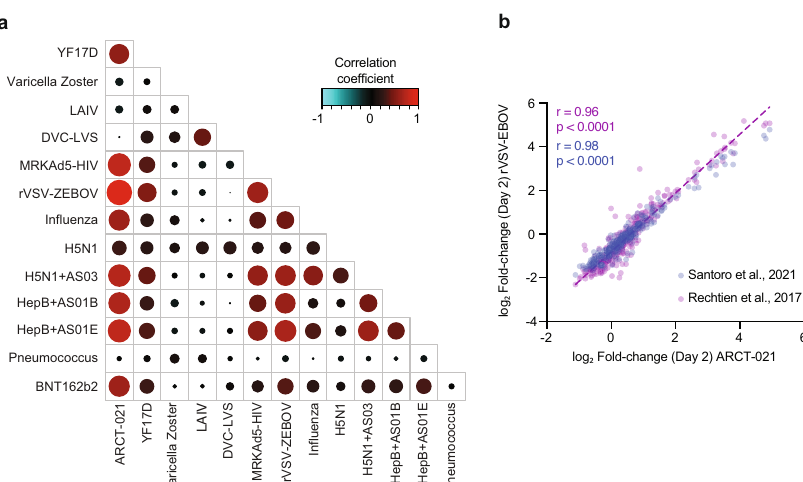
Fig. 4 ARCT-021 gene signatures are correlated with live viral vectors, adjuvanted and mRNA vaccines. a Correlation matrix showing pairwise correlations of the mean gene log2-transformed fold changes between the different vaccines at time-points with peak transcriptional responses. Transcriptional responses peaked on day 7 for live-attenuated vaccines and Pneumovax, day 3 for H5N1 and day 1 for all other vaccines. Size and intensity of dots are proportional to the magnitude of correlation coef fi cient. b Pearson correlation of log2-transformed fold-changes of transcripts in subjects receiving rVSV-ZEBOV vs ARCT-21 at day 1 post-vaccination 26,27 . r = correlation coef fi cient, p = signi fi cance of